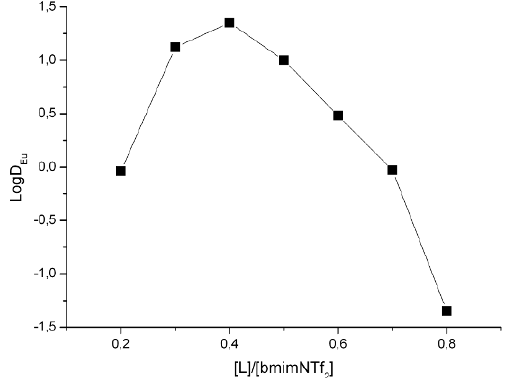
Figure 6. Extraction of Eu(III) from 1.10 -5 M Eu(NO with a mixture of compound 8 and [bmim][NTf dichloroethane. [ 8 ] + [IL] = 0.005 M.